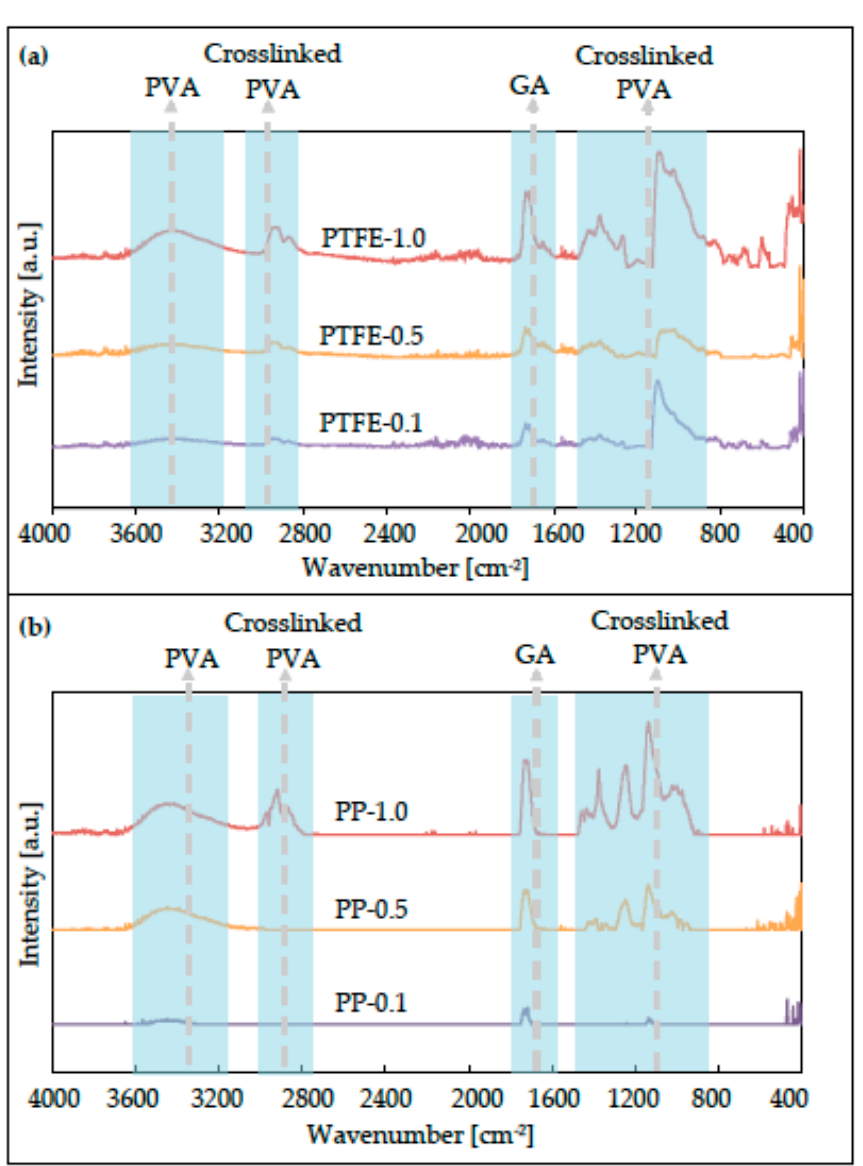
Figure 3. Spectra of PVA-coated feed side (PTFE) ( a ) and permeate side (PP) ( b ) subtracted from pristine spectra of untreated PTFE and polypropylene (PP) surfaces of the membrane, respectively. Highlighted with blue are the bands that represent pertinent to this work’s modification chemical bond groups of PVA, glutaraldehyde (GA), and cross-linked PVA.